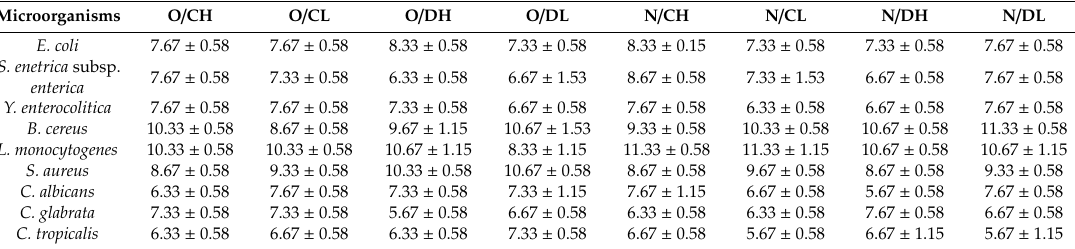
Table 5. Antimicrobial activity of